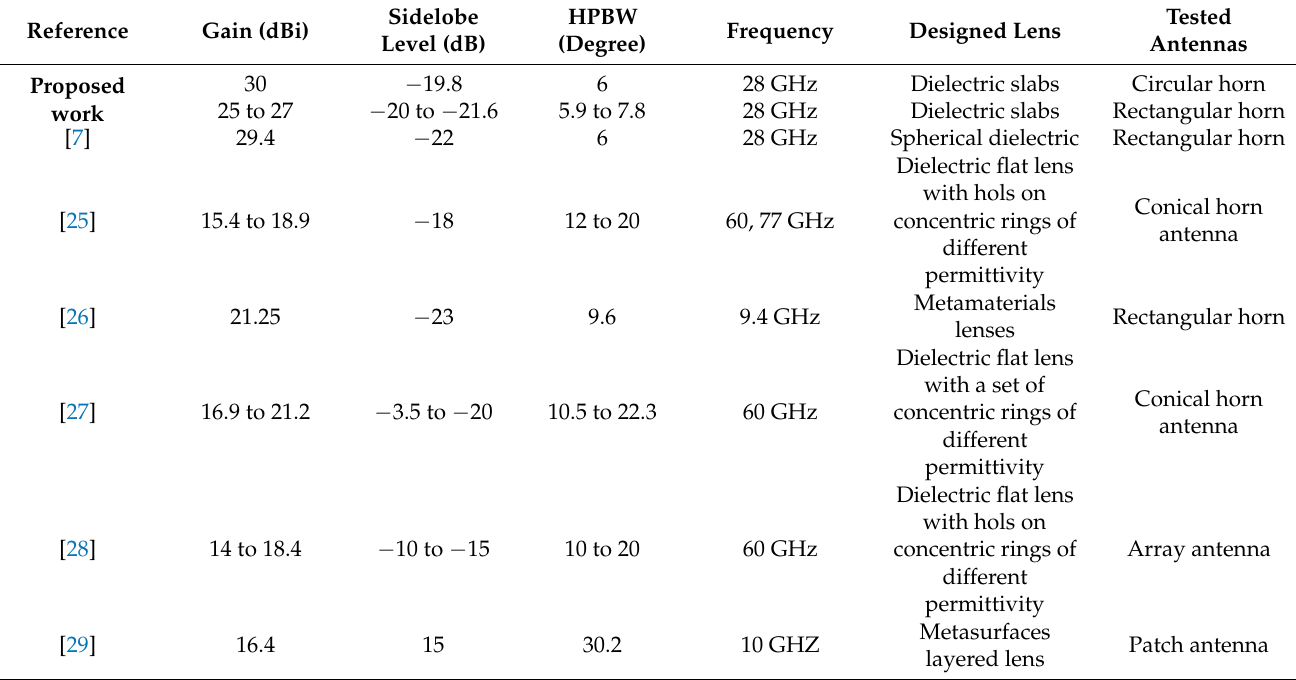
Table 2. Comparison of the proposed lens with other